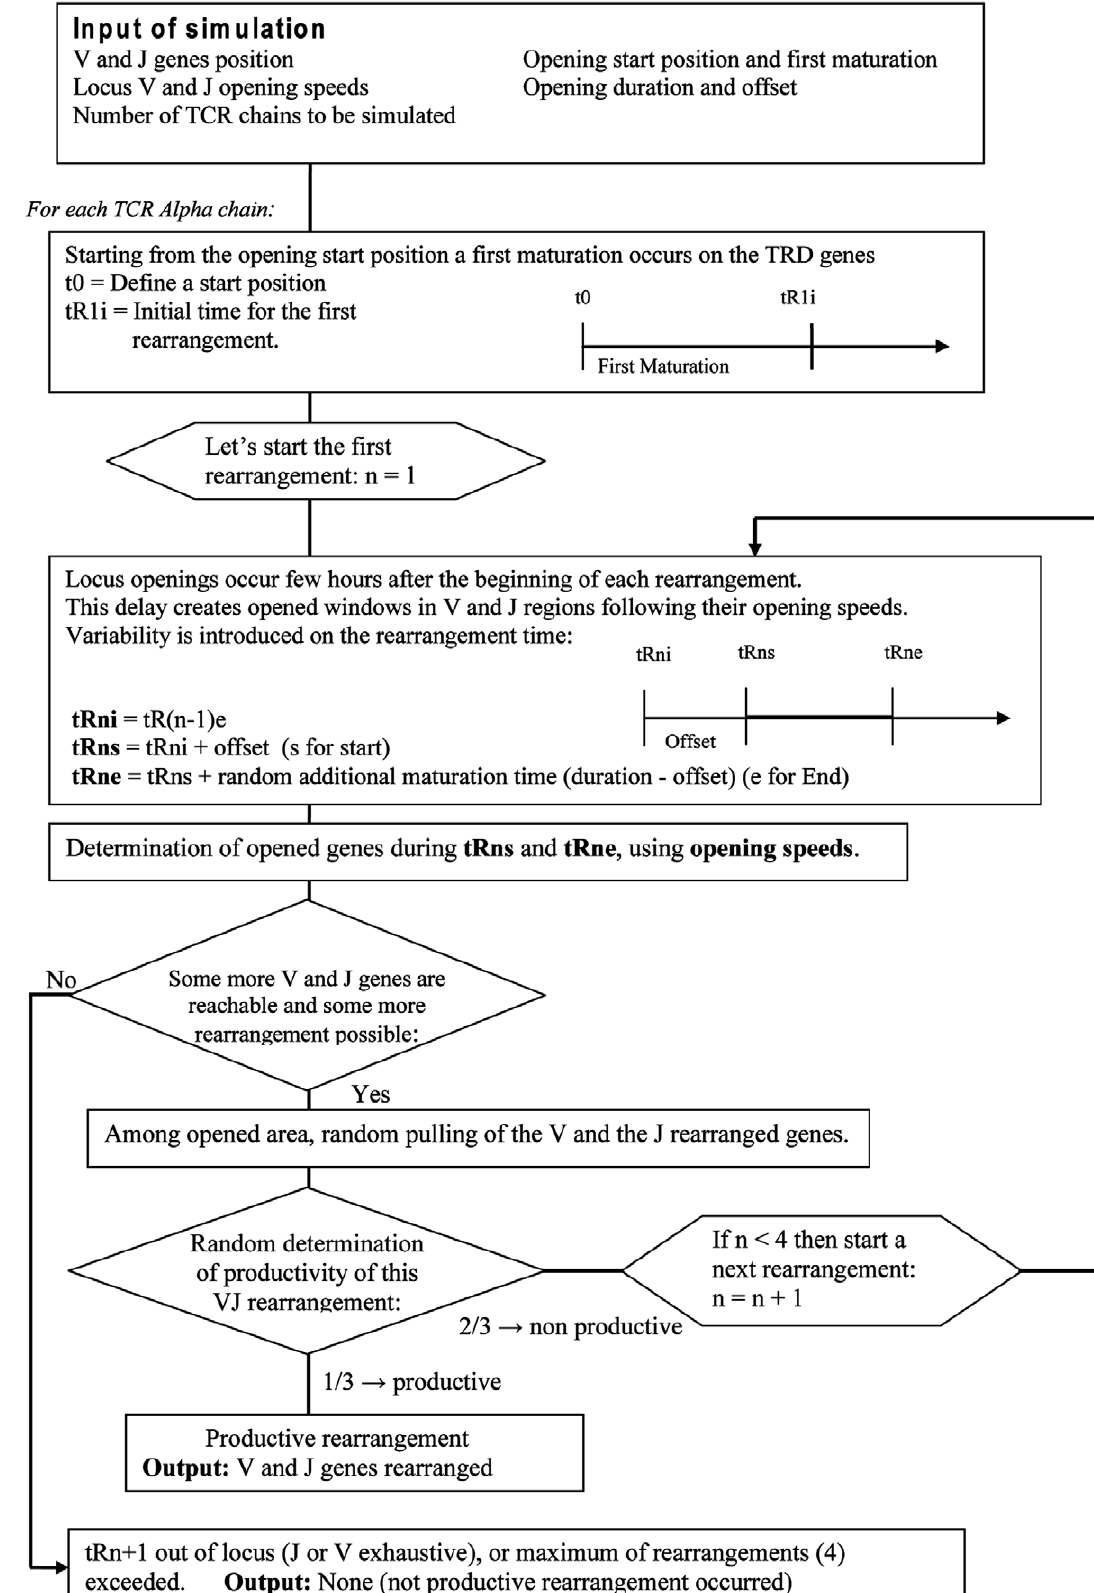
Figure 10. Flow diagram for the sequential windowing model algorithm.